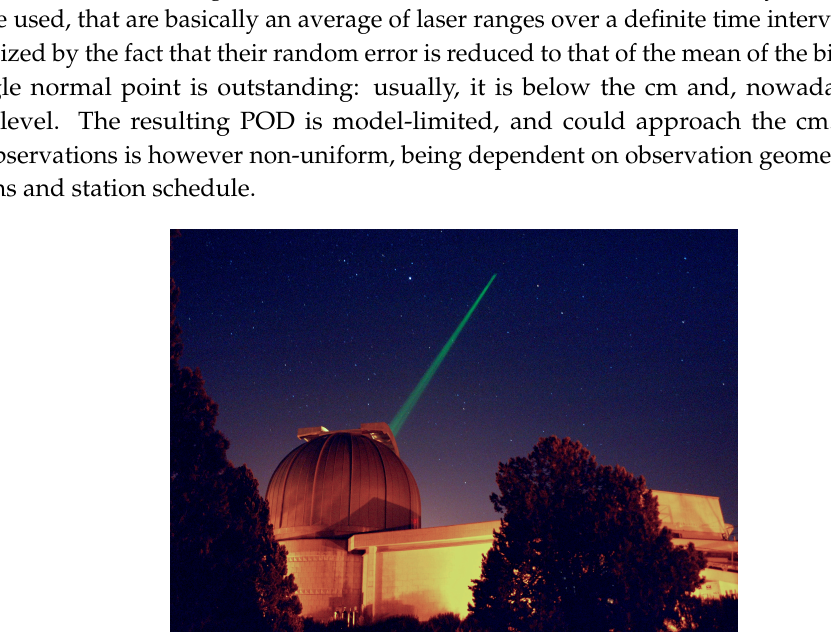
Figure 8. Matera laser station during a pass. Photo by Franco Ambrico. Courtesy Giuseppe Bianco,